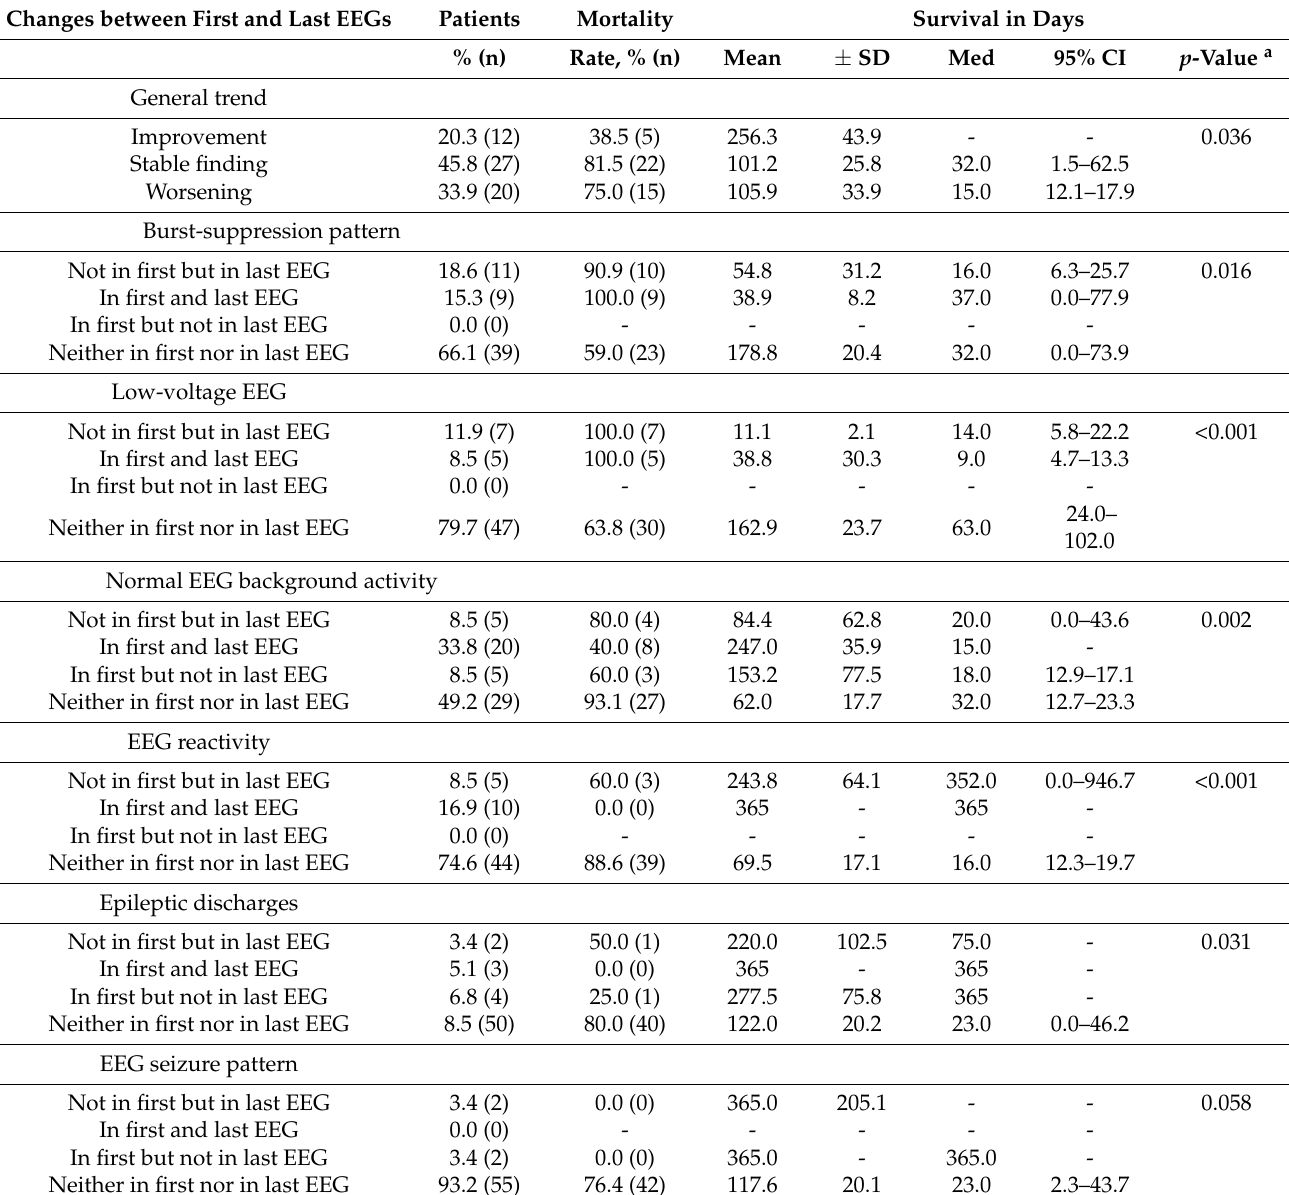
Table 3. Univariate analysis of predictive properties of rEEG parameters in patients with HE after CPR (n =